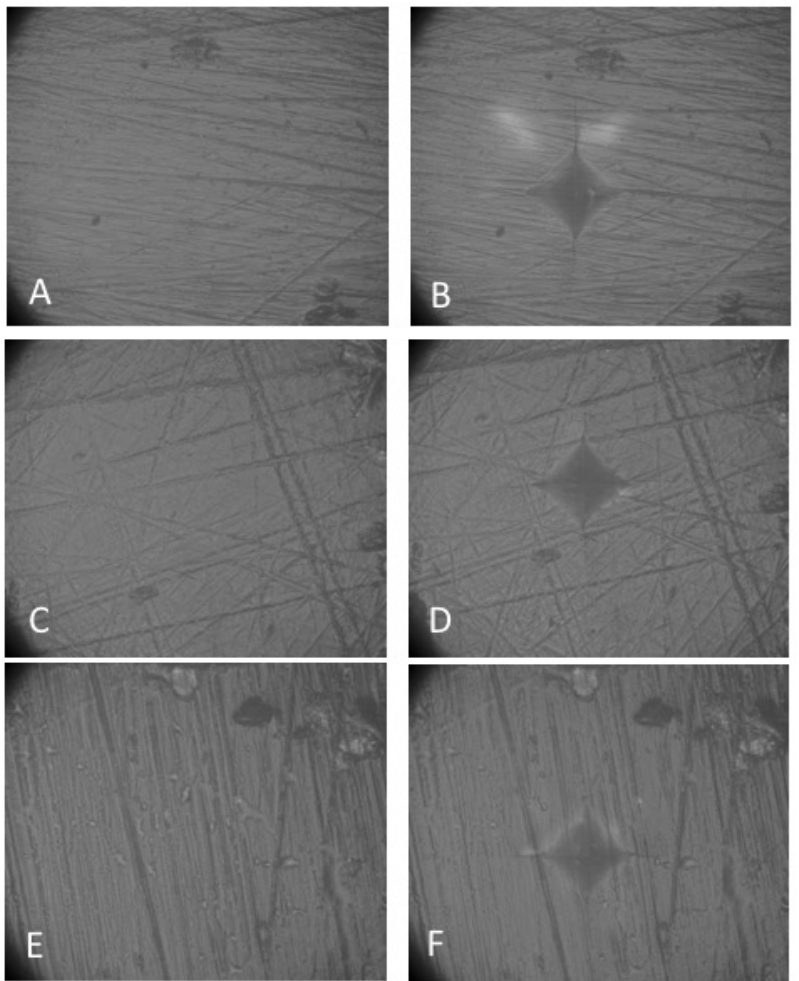
Figure 5. Photomicrographs of reinforced glass ceramic (VITA SUPRINITY ® PC) before and after immersion in acidic drink for 7 and 28 days (40× magnification). ( A , B ) Before immersion; ( C , D ) after immersion in acidic drink for 7 days, ( E , F ) after immersion in acidic drink for 28 days.